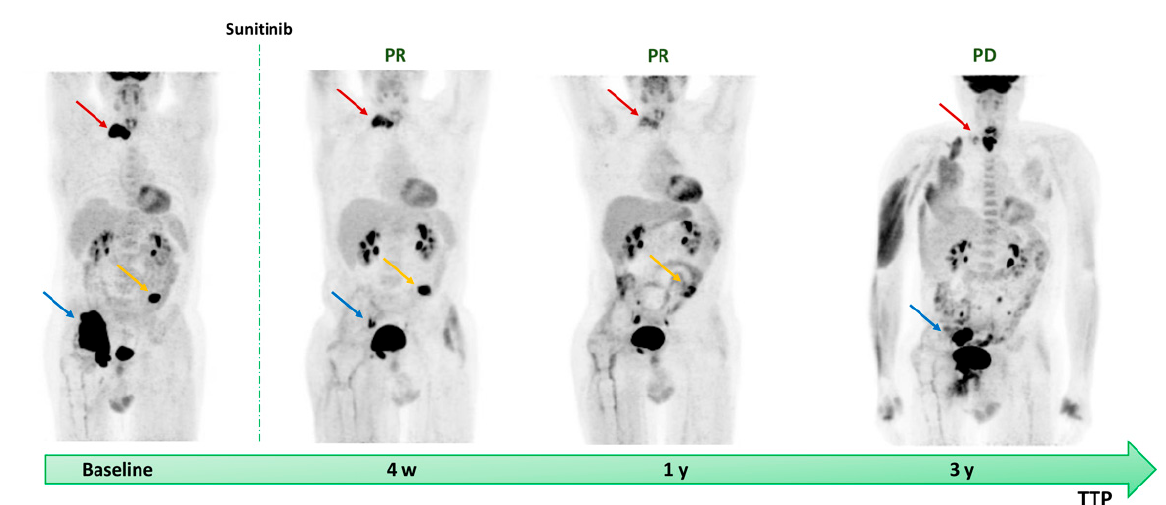
Figure 1. A 52 year-old man affected by metastatic RAI-R DTC. The patient underwent [ 18 F]FDG PET/CT before starting “off-label” Sunitinib therapy. The baseline PET showed high uptake in the transverse process of D1 (red arrow), left iliac wing (yellow arrow), and in the right hip, involved adjacent soft tissue (blue arrow). The patient first underwent right hip resection and reconstruction with a graft, then started MKI therapy and repeated PET exam after 28 days from the starting of Sunitinib with partial response. No AEs were reported and the patient continued target therapy. The one-year follow-up showed a significative response to Sunitinib therapy and a time to progression of three years. PR = partial response; PD = progression disease; w = week; y = year; TTP = time to tumor progression; RAI-R = refractory radioactive iodine; [ 18 F]FDG PET/CT = 2-deoxy-2-[ 18 F]fluoro-D-glucose positron emission tomography/computed tomography; MKIs = multi-kinase inhibitors; AEs = adverse events.